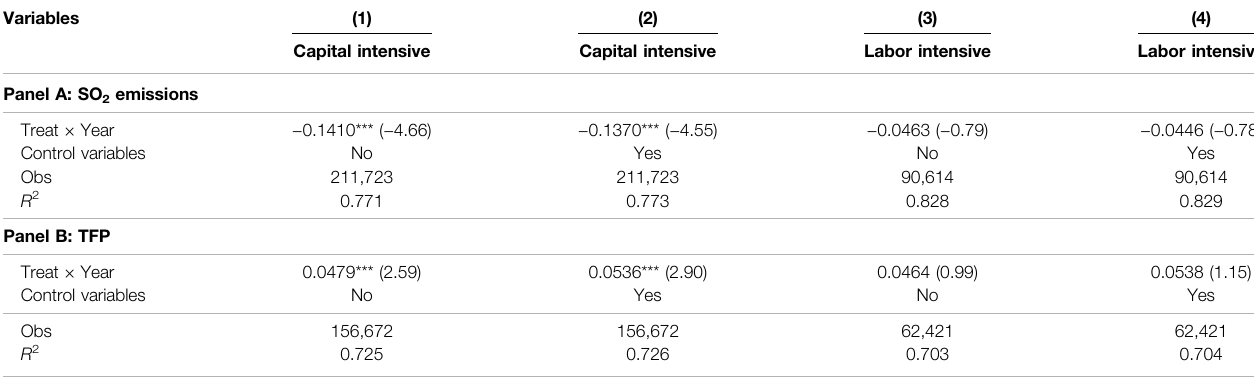
TABLE 9 | Heterogeneity regression results of factor intensity.